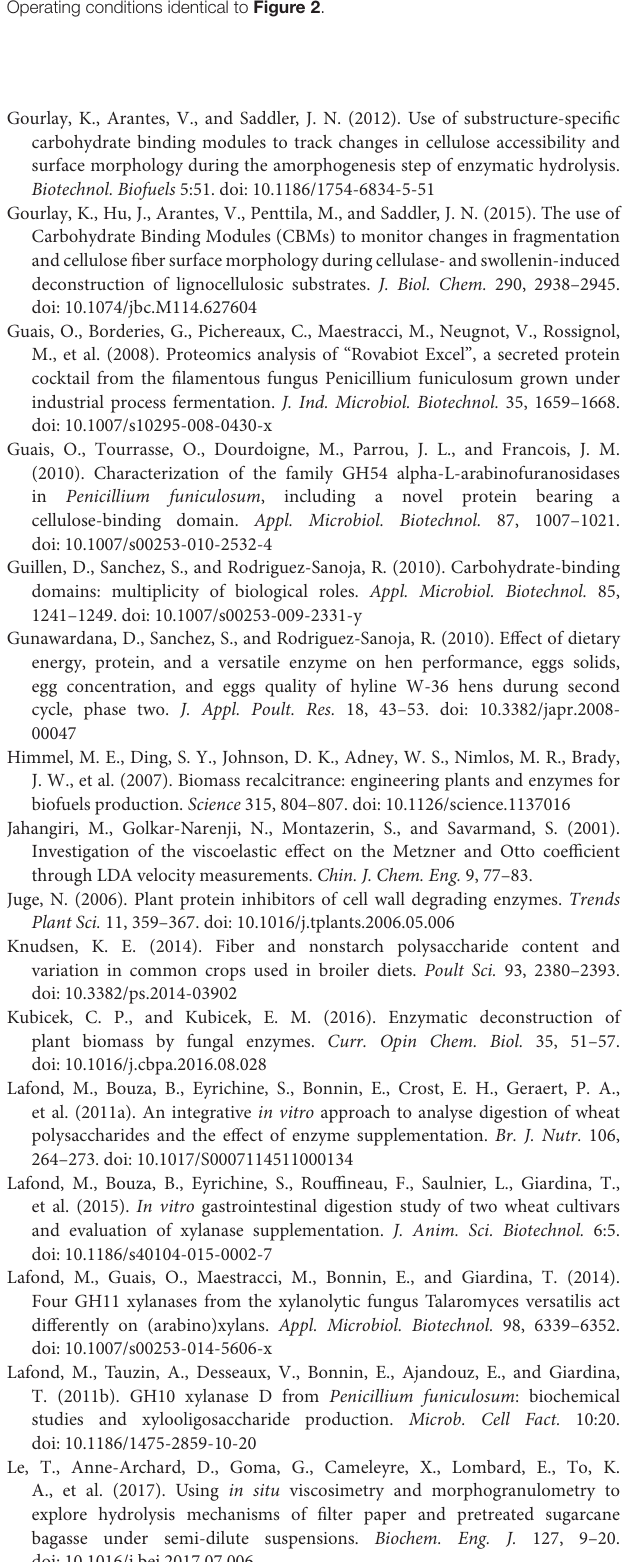
Table S1 | Sugars, proteins and total matter (%w/w initial dry matter) solubilized during enzymatic treatment of the destarched wheat bran by Rovabio Advance.